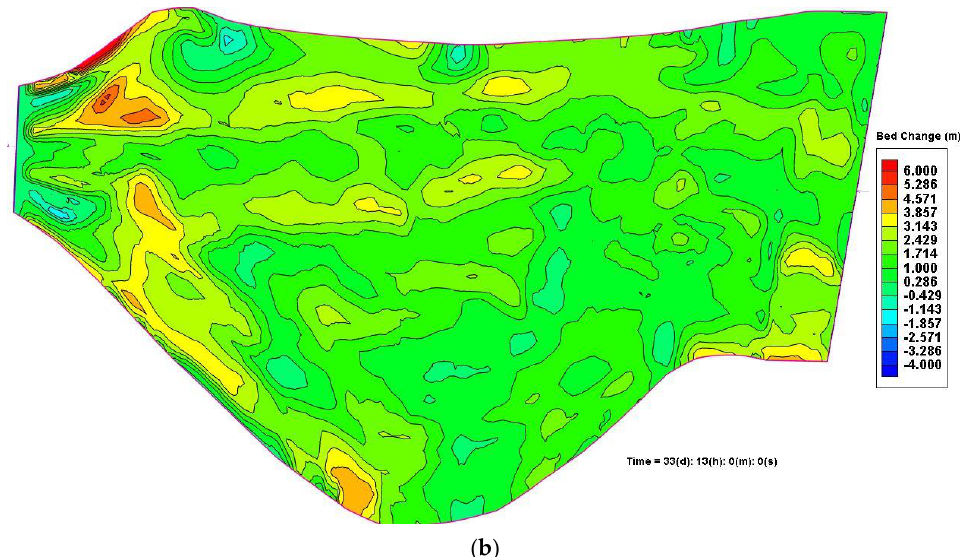
Figure 15. Bed changes from 2004 to 2007 in JiJi Reservoir. ( a ) Measured bed changes ( b ) Simulated bed changes.